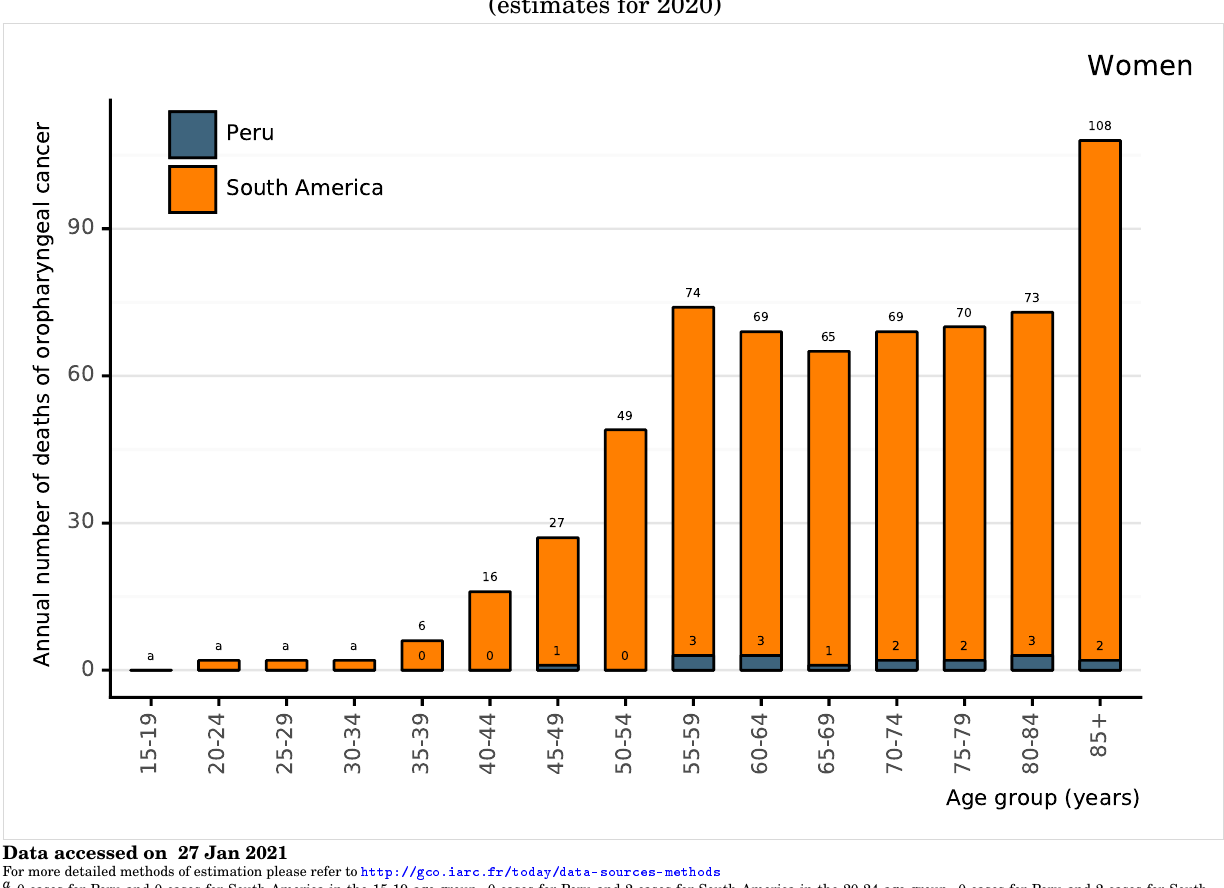
Figure 124: Annual number of deaths of oropharyngeal cancer among women by age group in